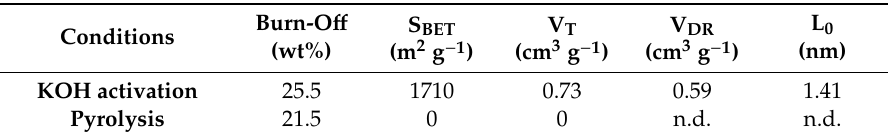
Table 3. Porosity parameters of semi-cokes obtained from pyrolysis of bituminous coal and a mixture of coal / KOH at the ratio of 1:4. Temperature ramp: 5 ◦ min − 1 . Final temperature: 520 ◦ C. Soaking time 2 h. Argon as a purge gas.